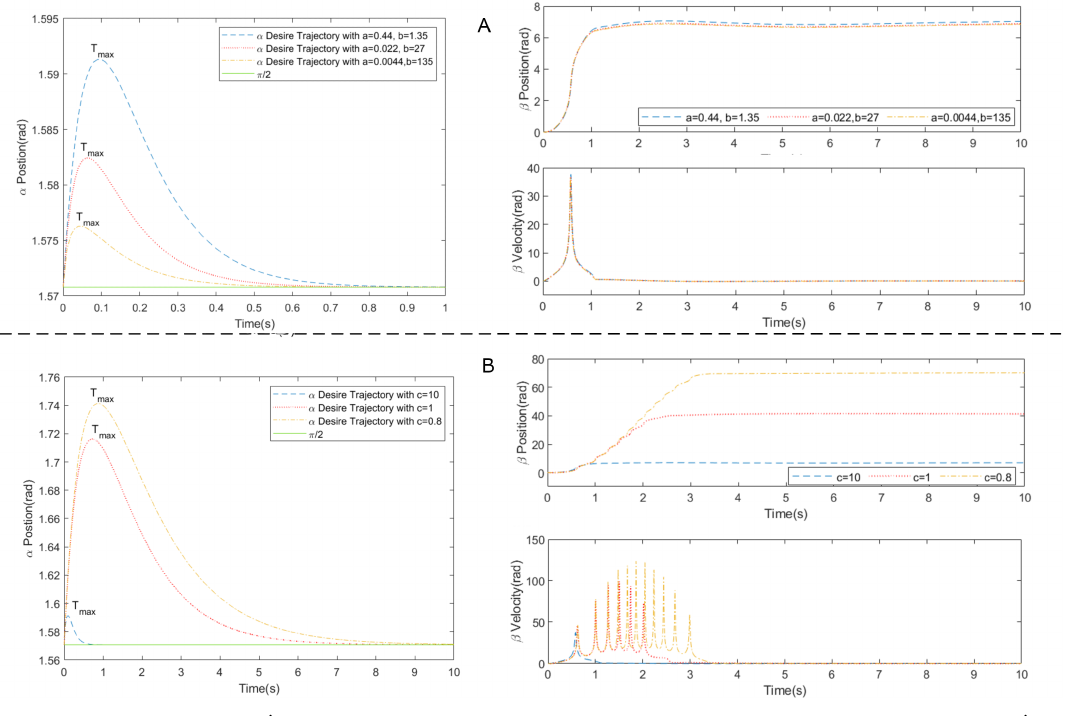
Figure 8. ( A ) α , β and ˙ β trajectories for c = 10 and d = π /2 and ˙ α 0 = 0.587 rad/s. ( B ) α , β and ˙ β trajectories for a = 0.44, b = 1.35, d = π /2 and ˙ α 0 = 0.587 rad/s with different c .